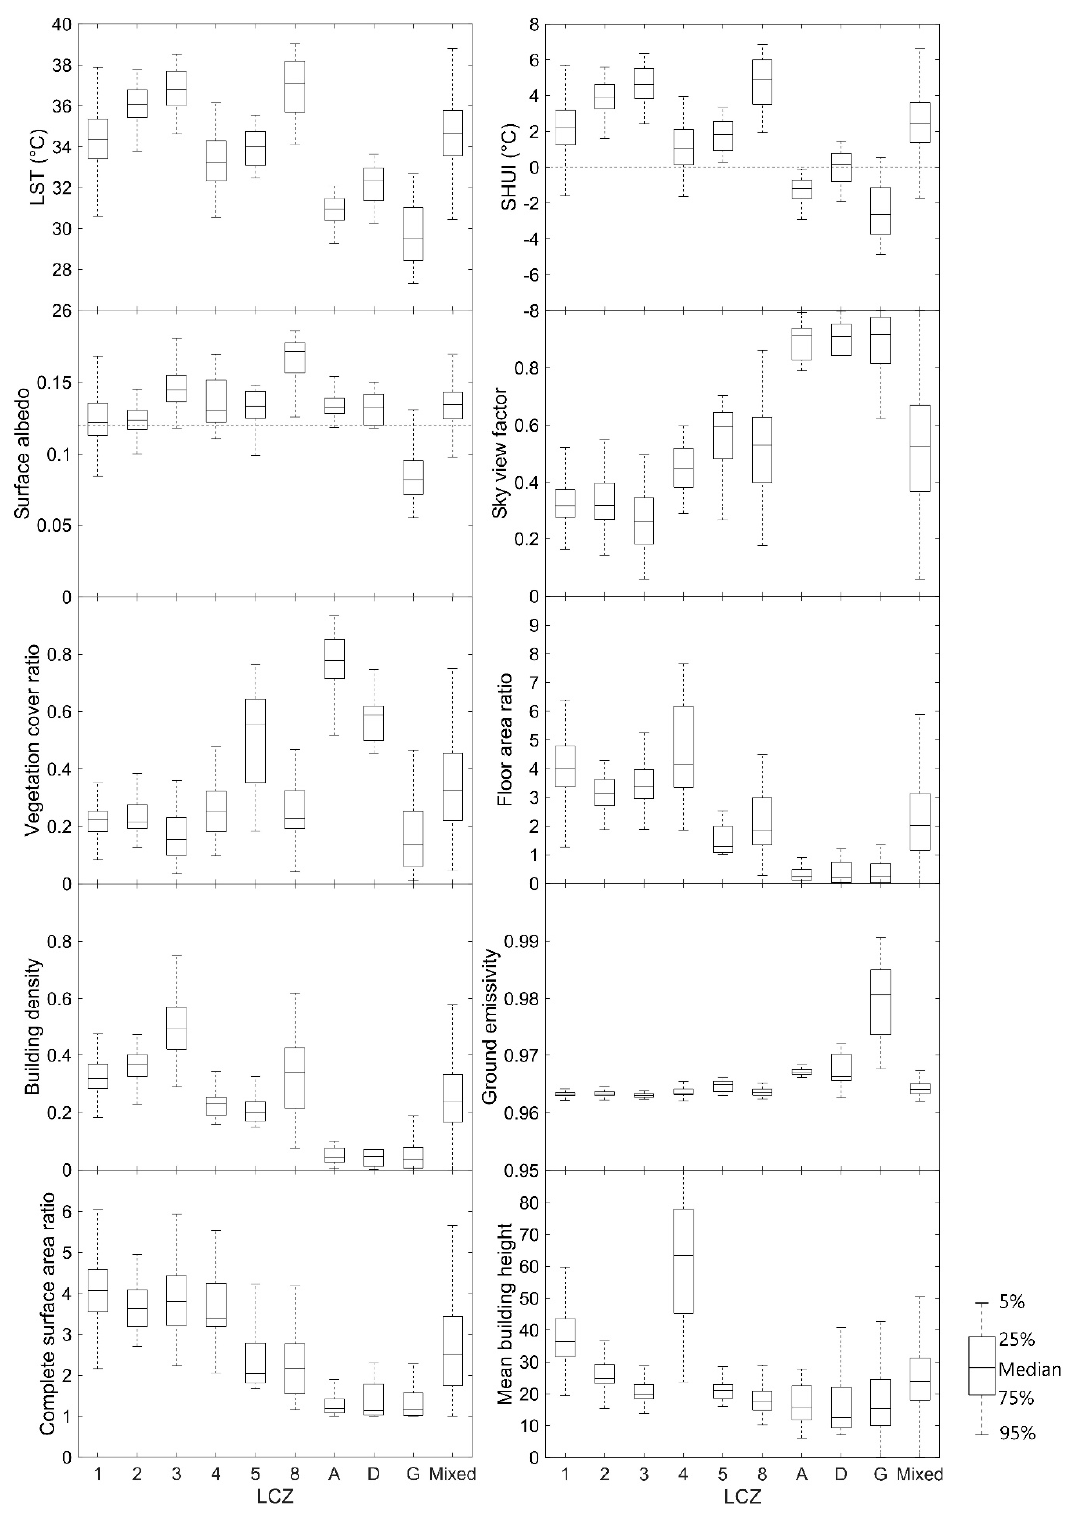
Figure 7. Box plots of LST, surface urban heat island (SUHI), and urban design factors for the LCZs in the central urbanized area of Guangzhou.